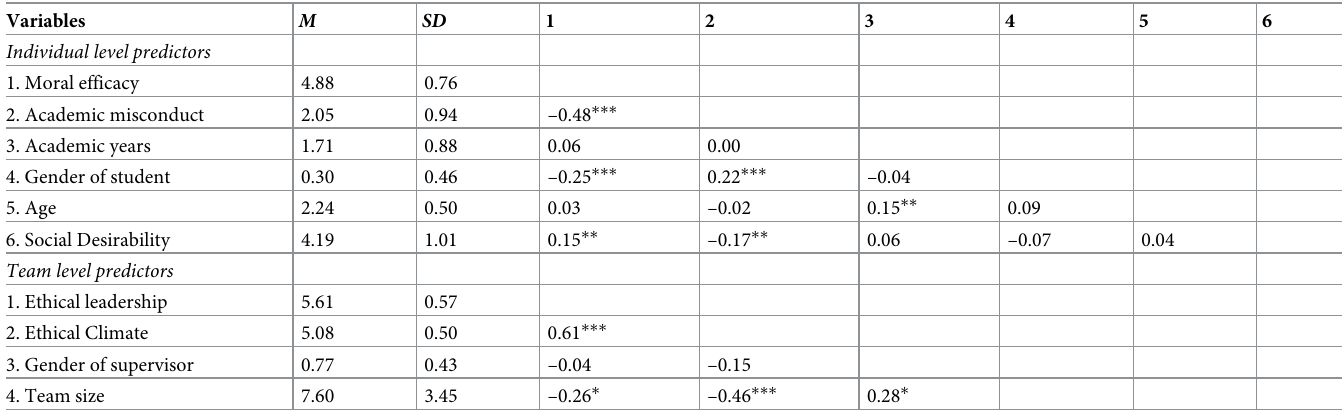
Table 1. Means, standard deviations, and correlations of the variables.